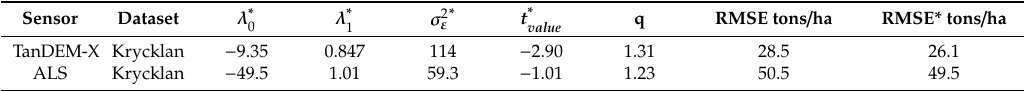
Table 2. Estimated parameters for the error models, t-scores corrected for regression dilution, q-values, RMSEs, and RMSE*s for the evaluations in the Krycklan test